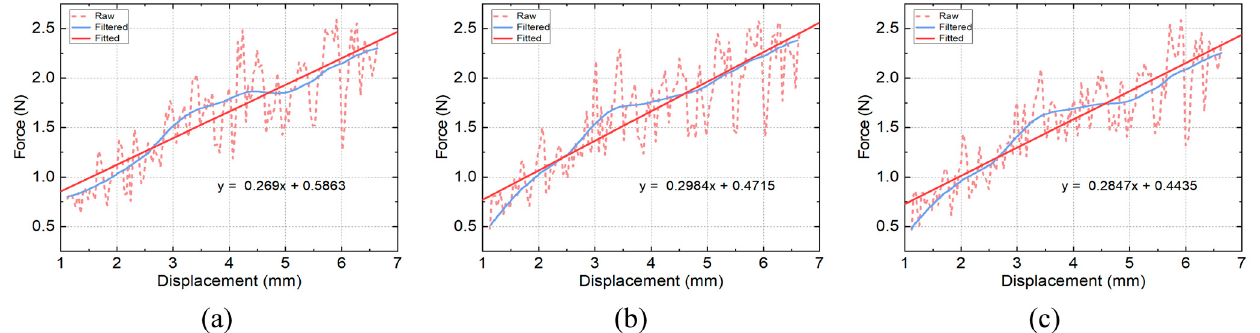
Figure 6. Measurement and fitting results of the stretching experiment of the spring for three re- peated times. Force displacement curves of spring validation test obtained from ( a ) the first measurement, ( b ) the second measurement and ( c ) the third measurement.